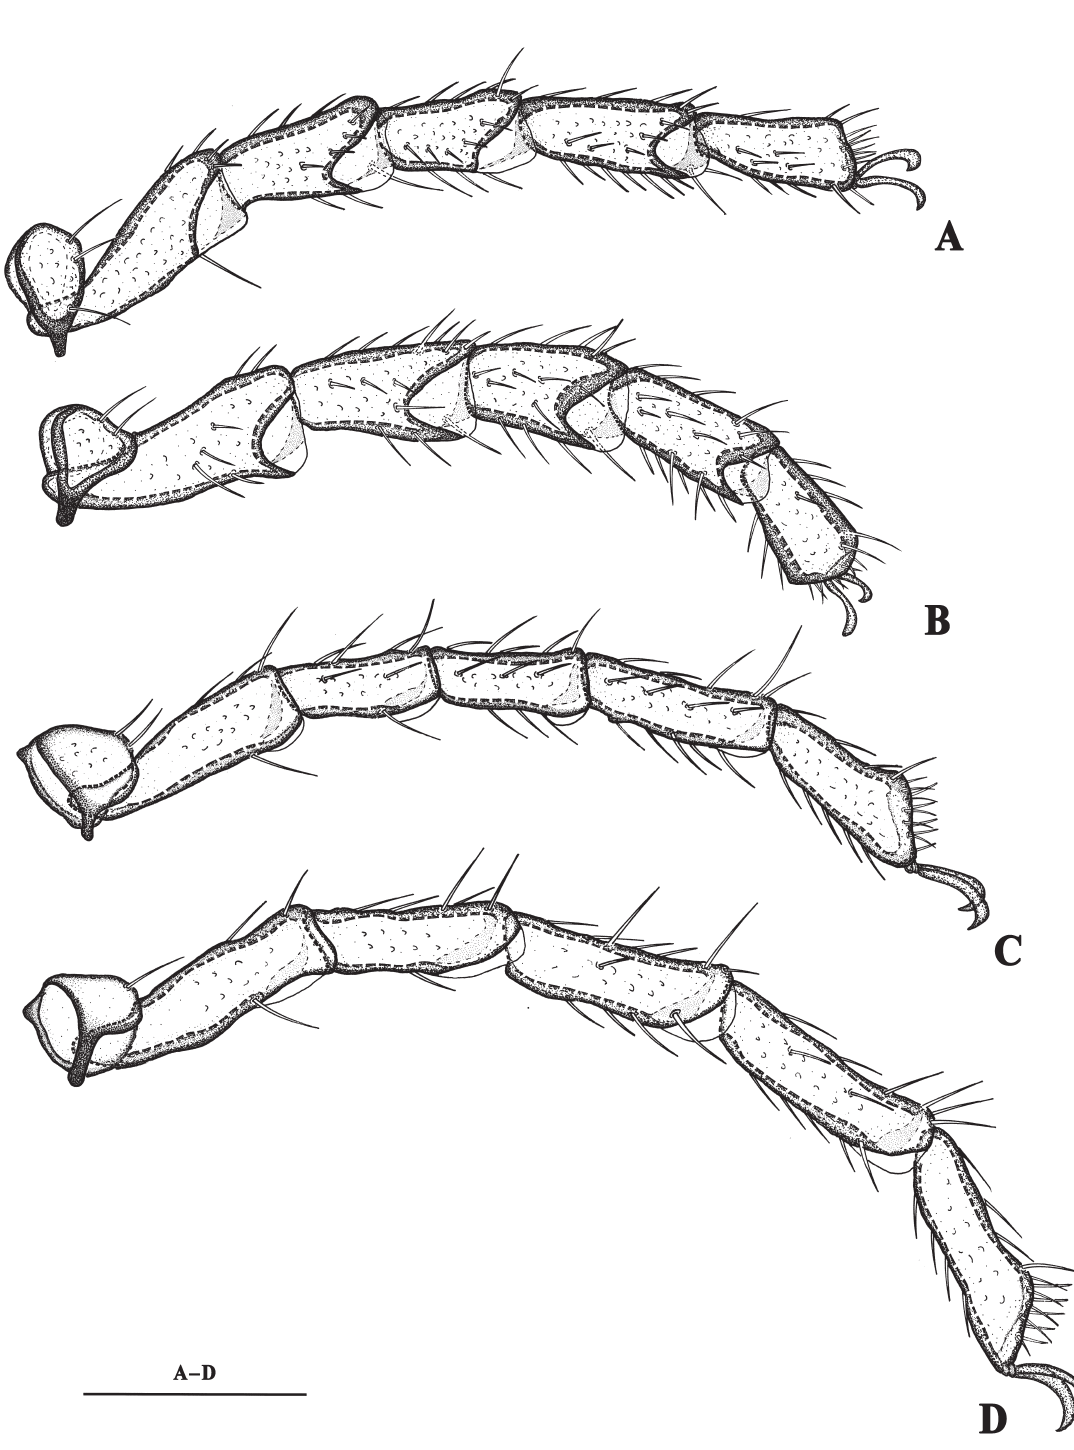
Fig. 9. Pentachares sinensis Li & Guo gen. et sp. nov., holotype, ♀ (GUGC GD-LI-20190801). A . I-L- 1–6. B . II-L-1–6. C . III-L-1–6. D . IV-L-1–6. Scale bar = 200